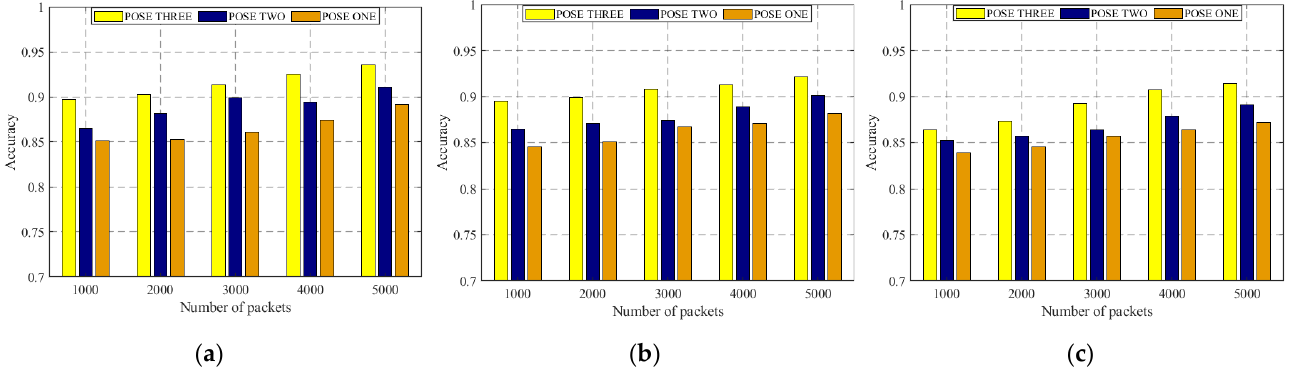
Figure 13. Accuracy of different CSI packet numbers. ( a ) Yoga classroom; ( b ) laboratory; ( c ) dormi- tory.